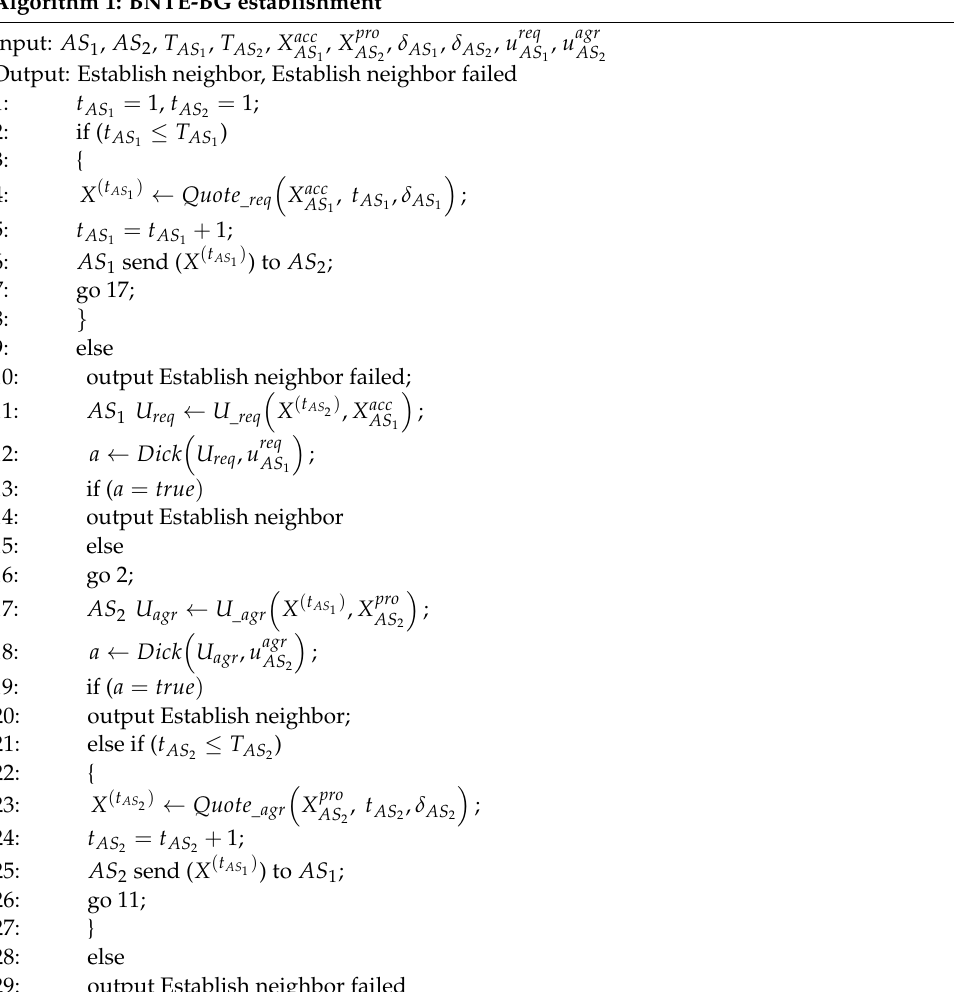
Algorithm 1: BNTE-BG